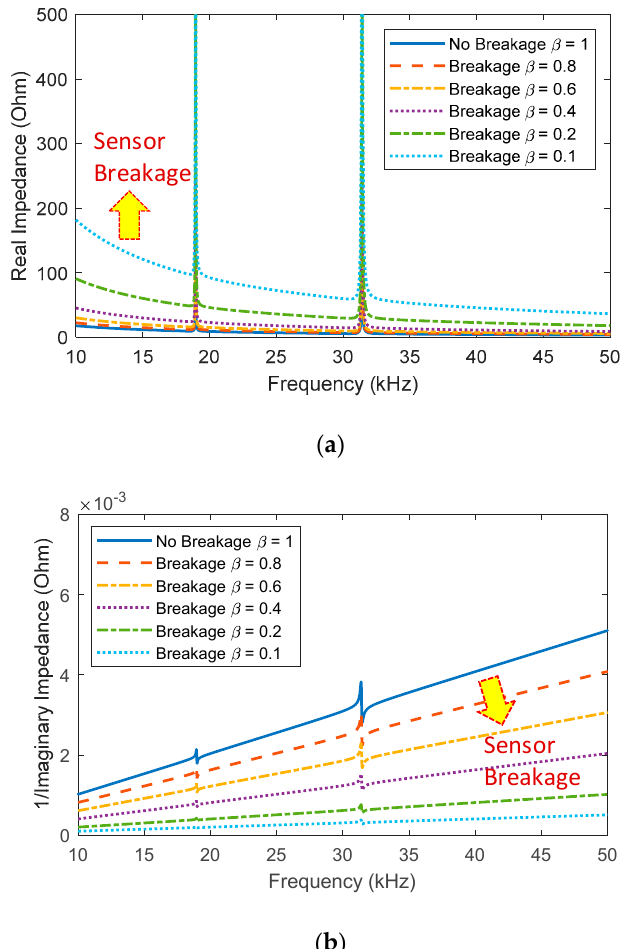
Figure 12. Analytical impedance signatures under the sensor breakage effect: ( a ) real part in 10–50 kHz; ( b ) imaginary part in 10–50 kHz.